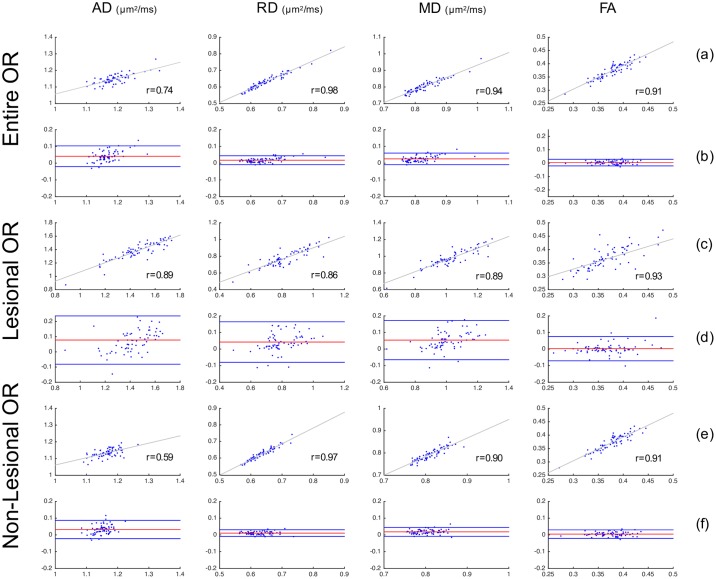
Comparison of OR diffusivity metrics between PT-OR and Histology-OR approaches.Row (a), (c), (e) are scatter plots with linear fitting; x-axis is PT-OR measurement and y-axis is Histology-OR measurement. r is the Pearson’s correlation coefficient. Row (b), (d), (f) are Bland-Altman plots for comparing two methods. x-axis is the mean of PT-OR and Histology-OR measurements. y-axis is the difference between PT-OR and Histology-OR measurements.